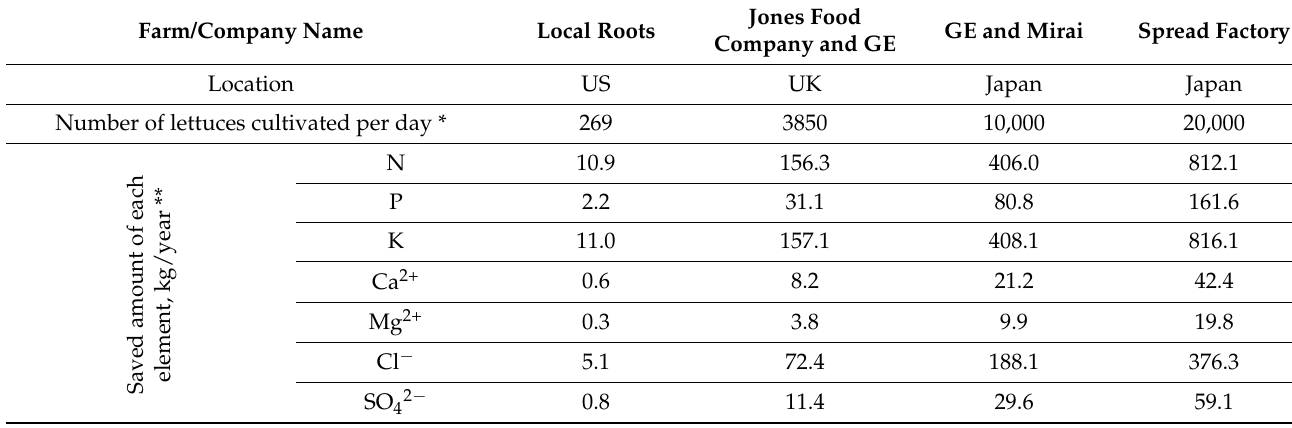
Table 7. Data from four indoor vertical farms producing lettuce using DNUE as the nutrient solution; calculated nutrient savings from the use of urine instead of commercial fertilizer; estimate of the number of people required to donate urine daily to ensure adequate nutrient